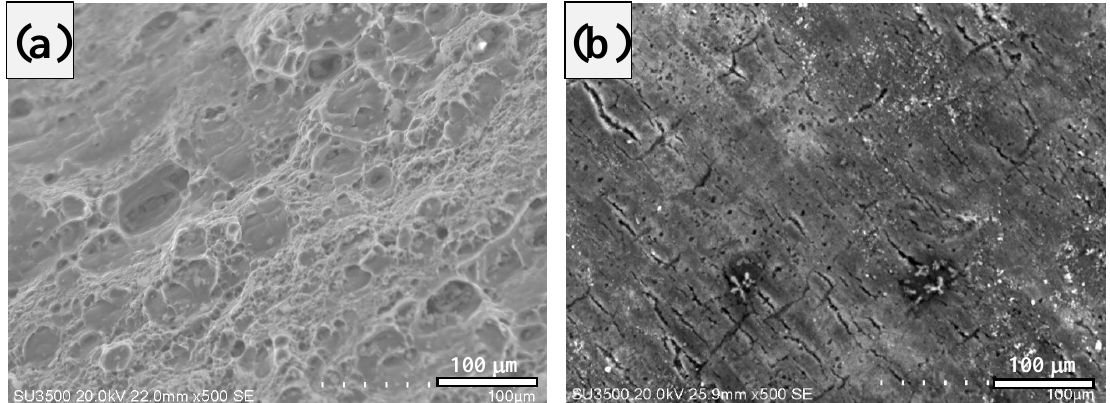
Figure 10. EIS results (Nyquist plots) for standard rebar and DP steel in 0.3 M NaHCO 3 + 0.1 M Na 2 CO 3 (pH = 9.0) solution.